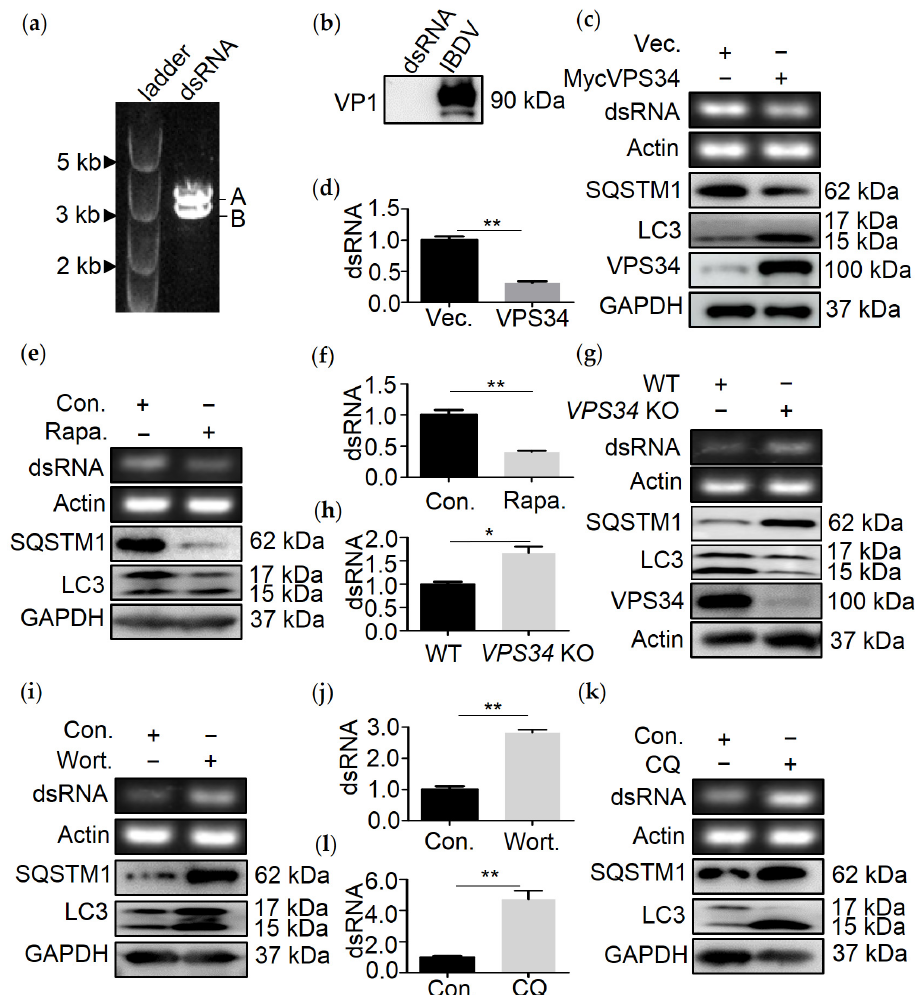
Figure 1. Autophagy promotes the degradation of IBDV dsRNA. ( a ) IBDV dsRNA was extracted from IBDV and separated by agarose gel electrophoresis. DsRNA consists of two bands, segment A (3.2 kb) and segment B (2.8 kb). ( b ) Extracted dsRNA or lysate of virus-infected cells was immunoblotted by using indicated antibody. QRT-PCR and PCR analysis of IBDV dsRNA and β -Actin mRNA from cells cotransfected with Myc-tag human VPS34 (VPS34) and dsRNA for 8 h ( c , d ), transfected with dsRNA for 8 h and treated with Rapa (5 µ M) for 4 h before collection ( e , f ), transfected with dsRNA for 8 h in knock out VPS34 (VPS34 KO) cell lines ( g , h ), transfected with dsRNA for 8 h and treated with Wort (20 nM) ( i , j ) or CQ (100 µ M) ( k , l ) for 4 h before collection. Data were represented as mean ± SD of three independent experiments. NS, not significant ( p > 0.05); * p < 0.05, ** p < 0.01.